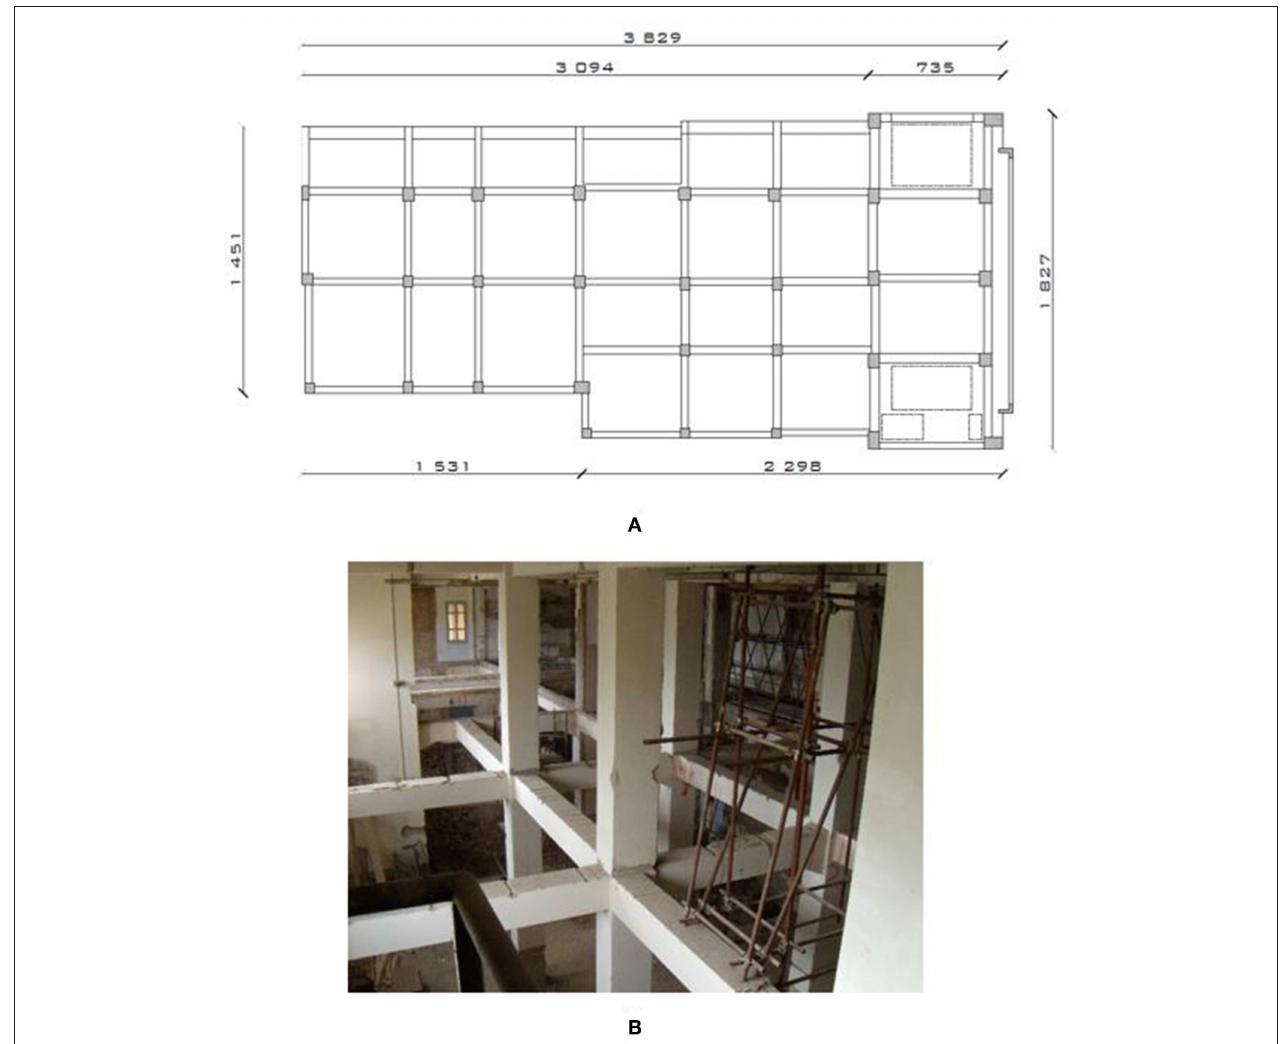
FIGURE 8 | Existing grid of RC beams. (A) Plan configuration (dimensions in centimeters), (B) view of current